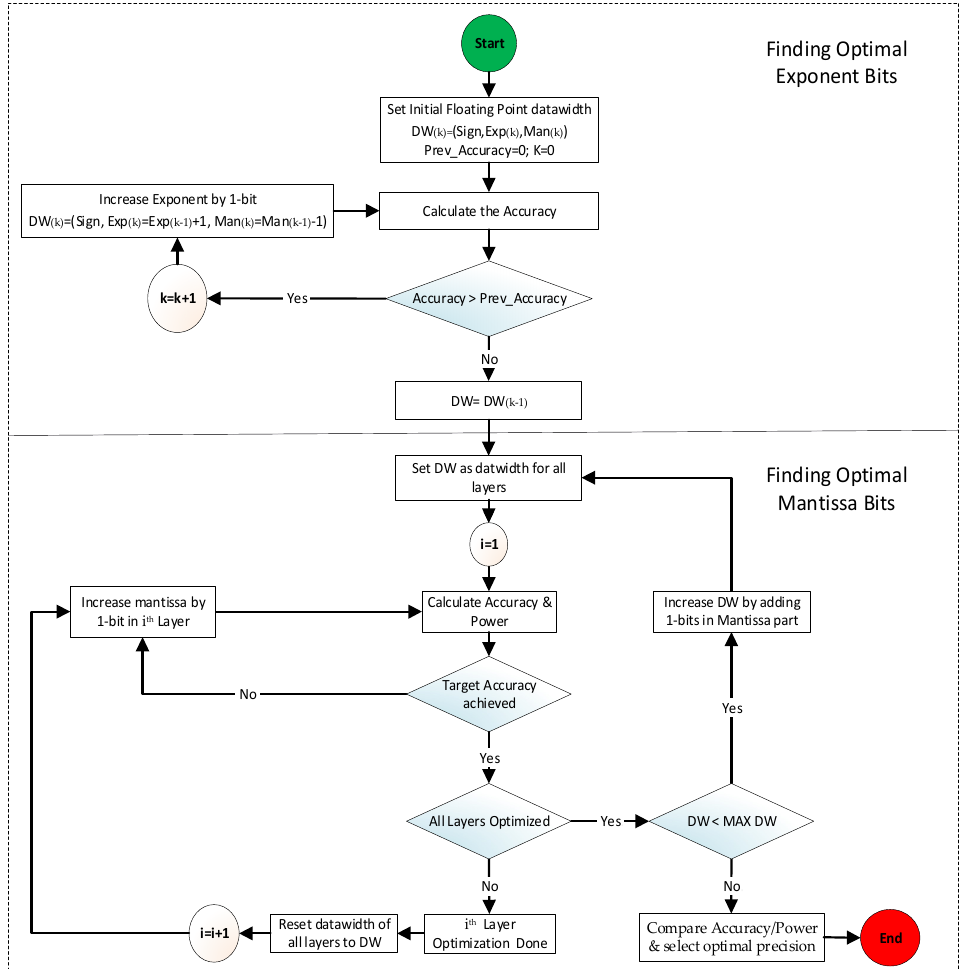
Figure 10. Arithmetic optimization algorithm.